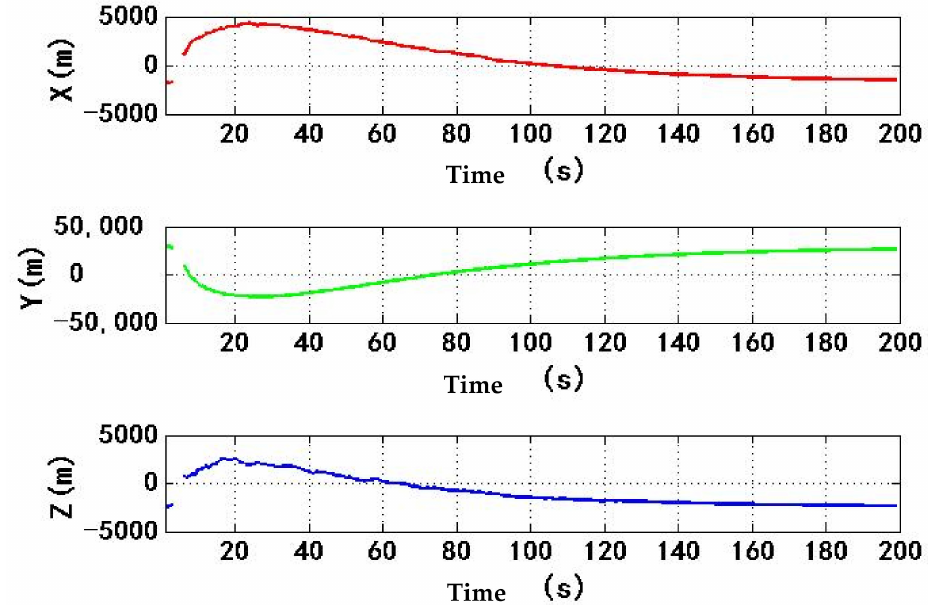
Figure 11. Changes in ECEF three dimensional coordinates of receiver in experiment